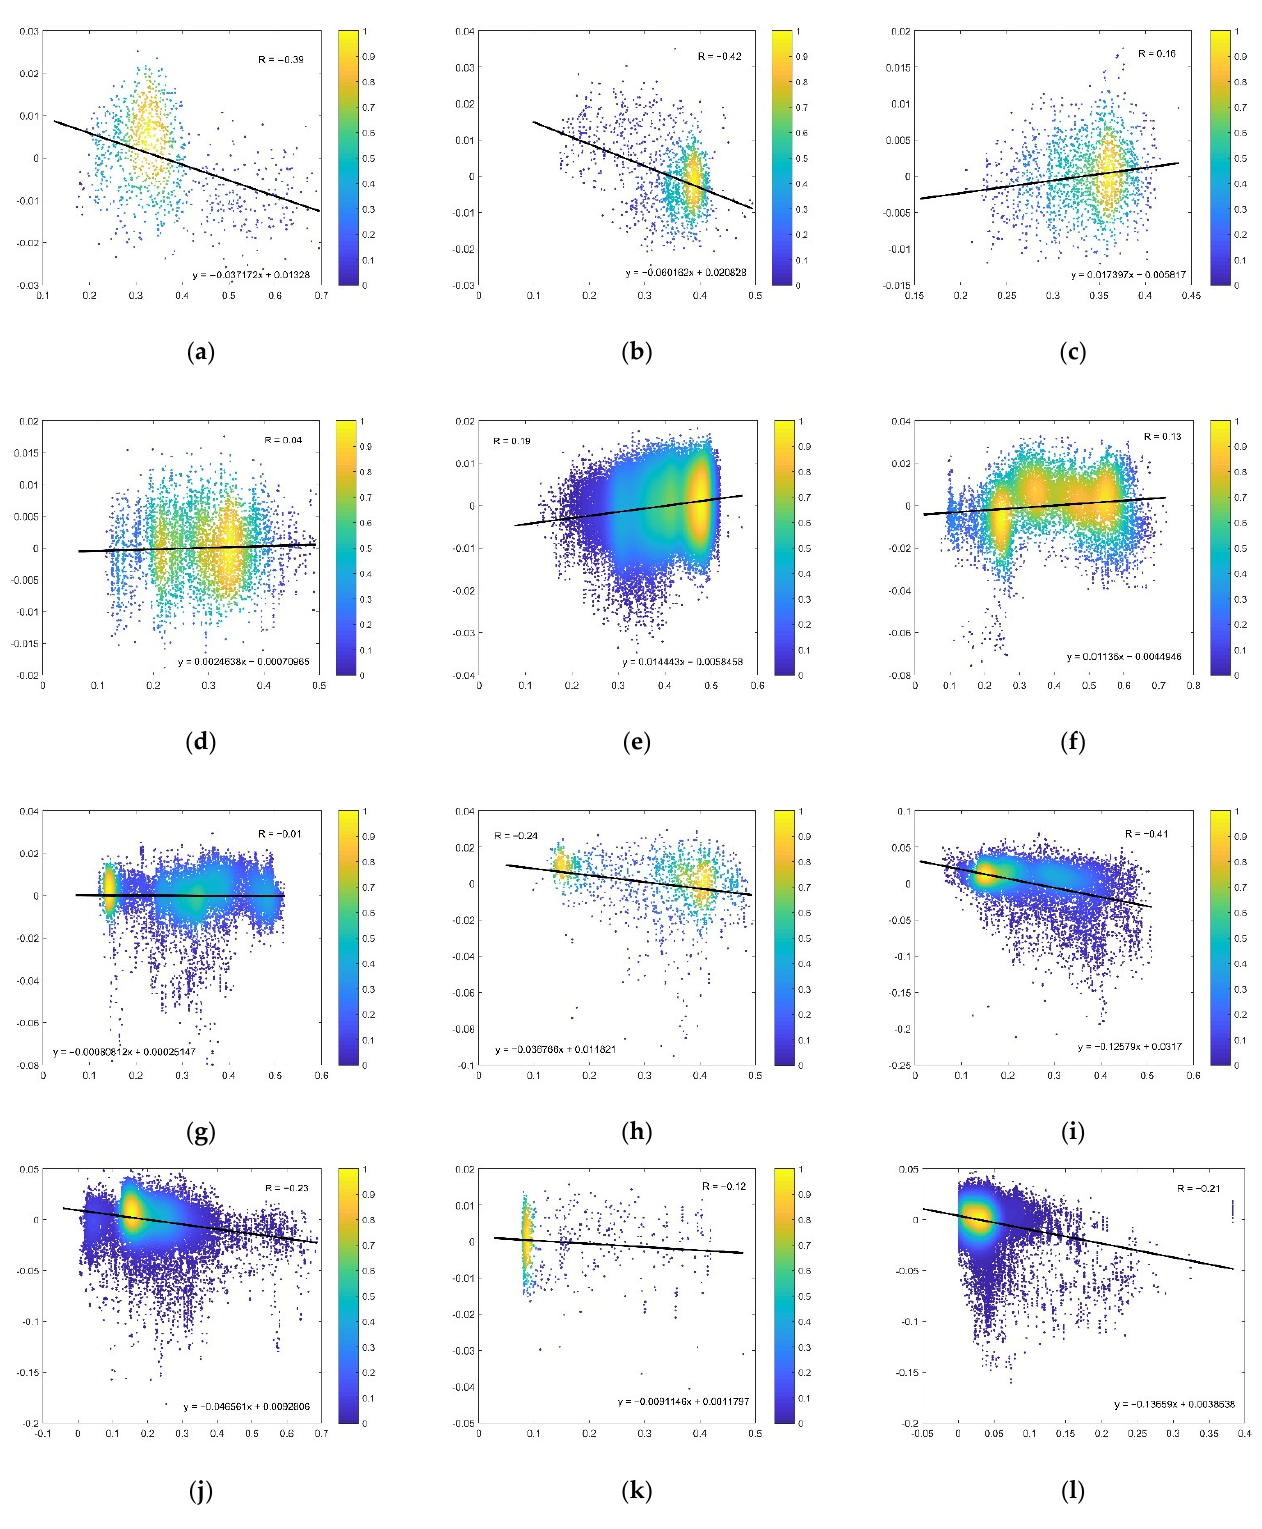
Figure 7. The density scatter diagrams between Delta2 (vertical axis) and SMC (horizontal axis) for the 12 vegetation types. ( a ) deciduous needleleaf forests; ( b ) evergreen needleleaf forests; ( c ) mixed forests; ( d ) deciduous broadleaf forests; ( e ) evergreen broadleaf forests; ( f ) woody savannas; ( g ) savannas; ( h ) cropland/natural vegetation mosaics; ( i ) croplands; ( j ) grasslands; ( k ) closed shrublands; ( l ) open shrublands.